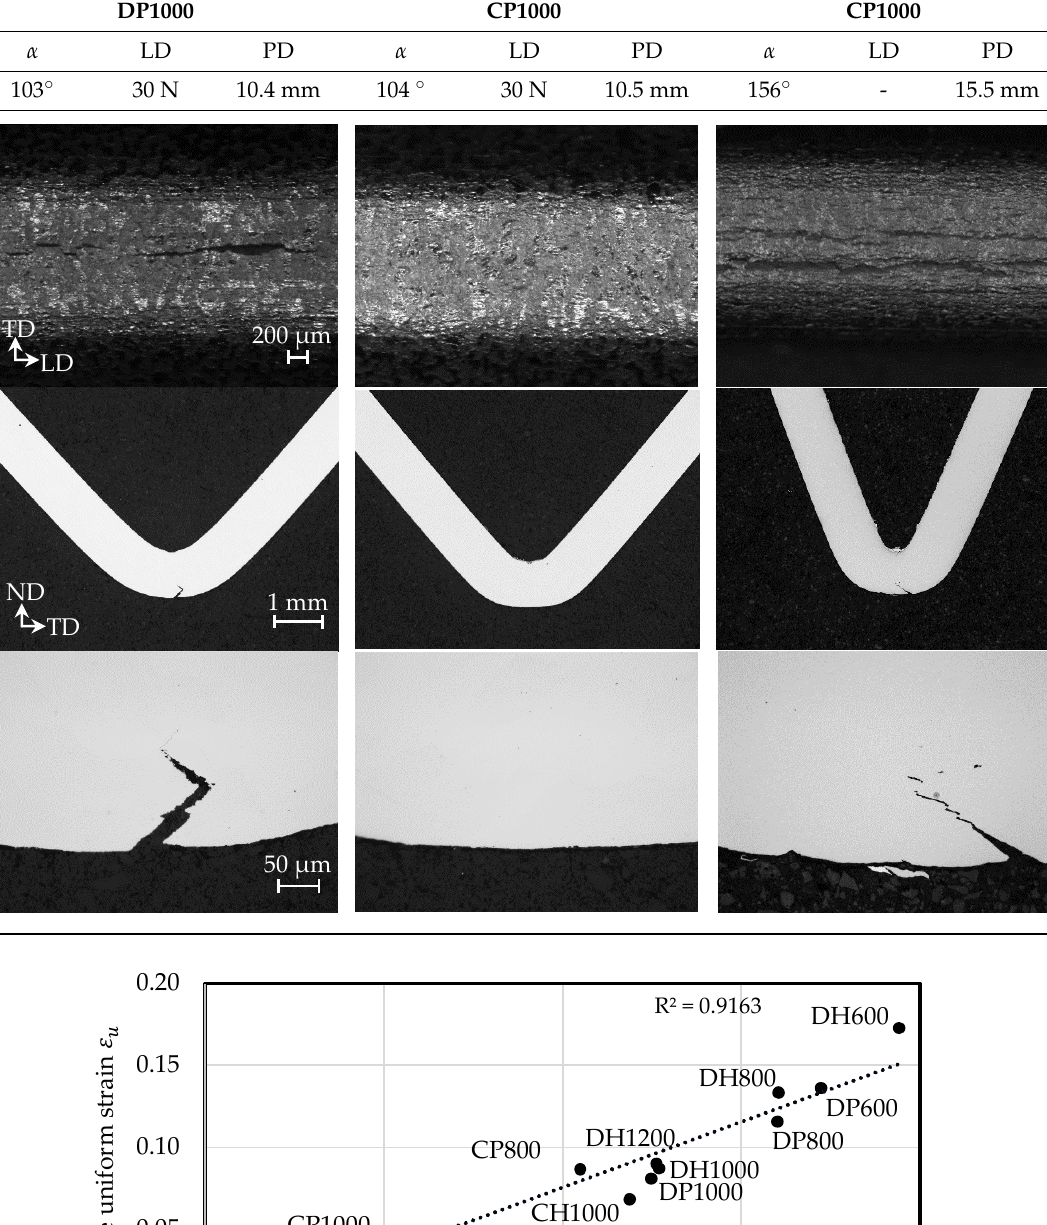
Table A18. Micrographs of bending specimens (LD: Load drop, PD: Punch displacement).